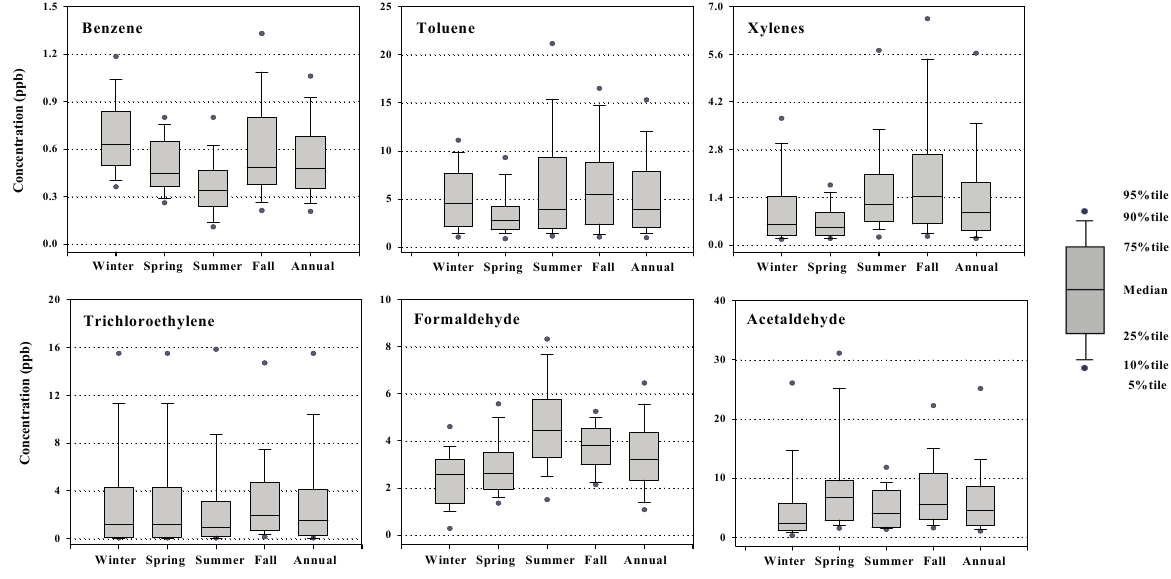
Figure 4. Seasonal variations of the selected VOCs at industrial site I during